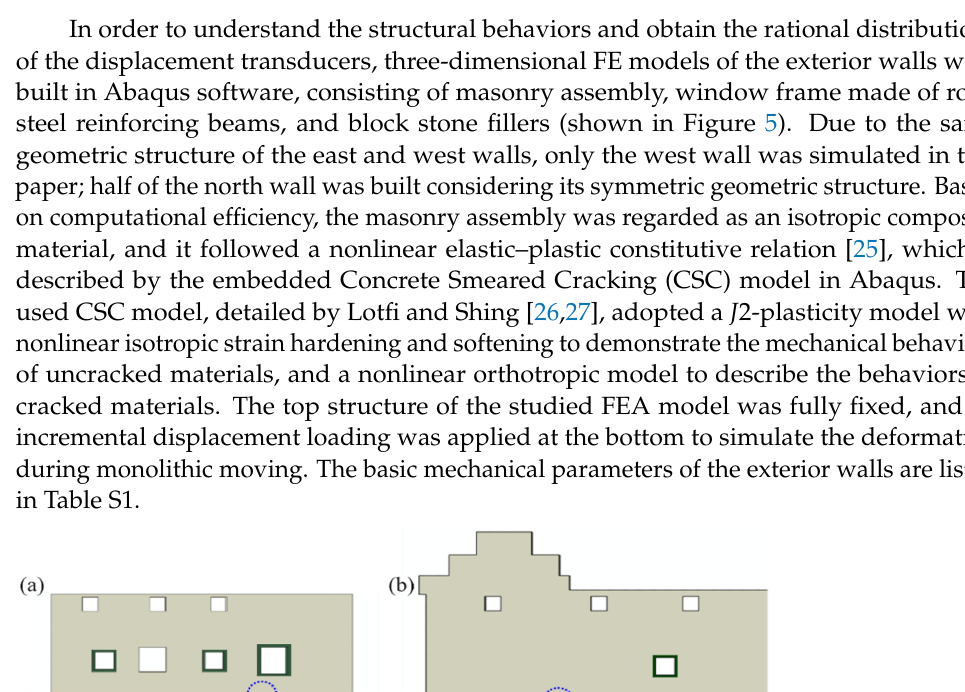
Figure 4. The WSN system schematic: ( a ) sensors (pointed with yellow arrows) and the correspond- ing acquisition devices (pointed with green arrows); ( b ) monitoring server; ( c ) wireless communication.